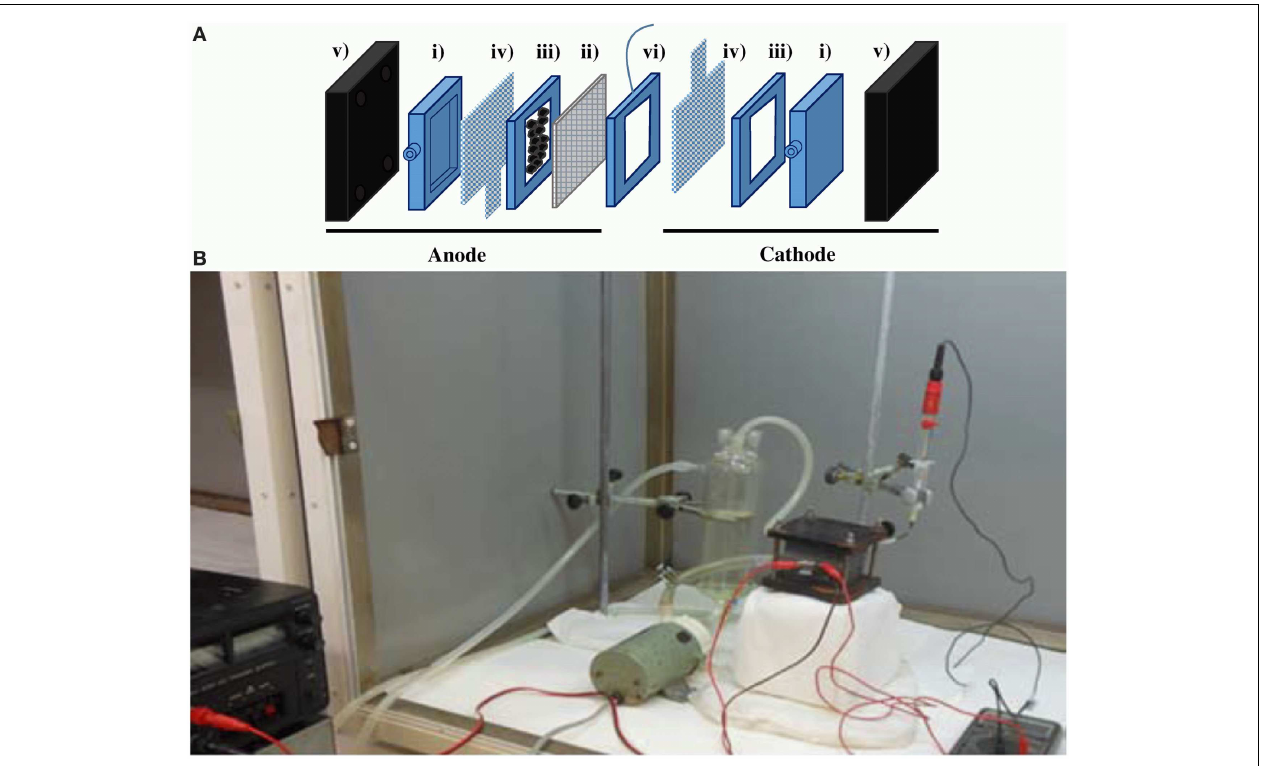
FIGURE 1 | (A) Scheme and (B) experimental set-up for the filter-press